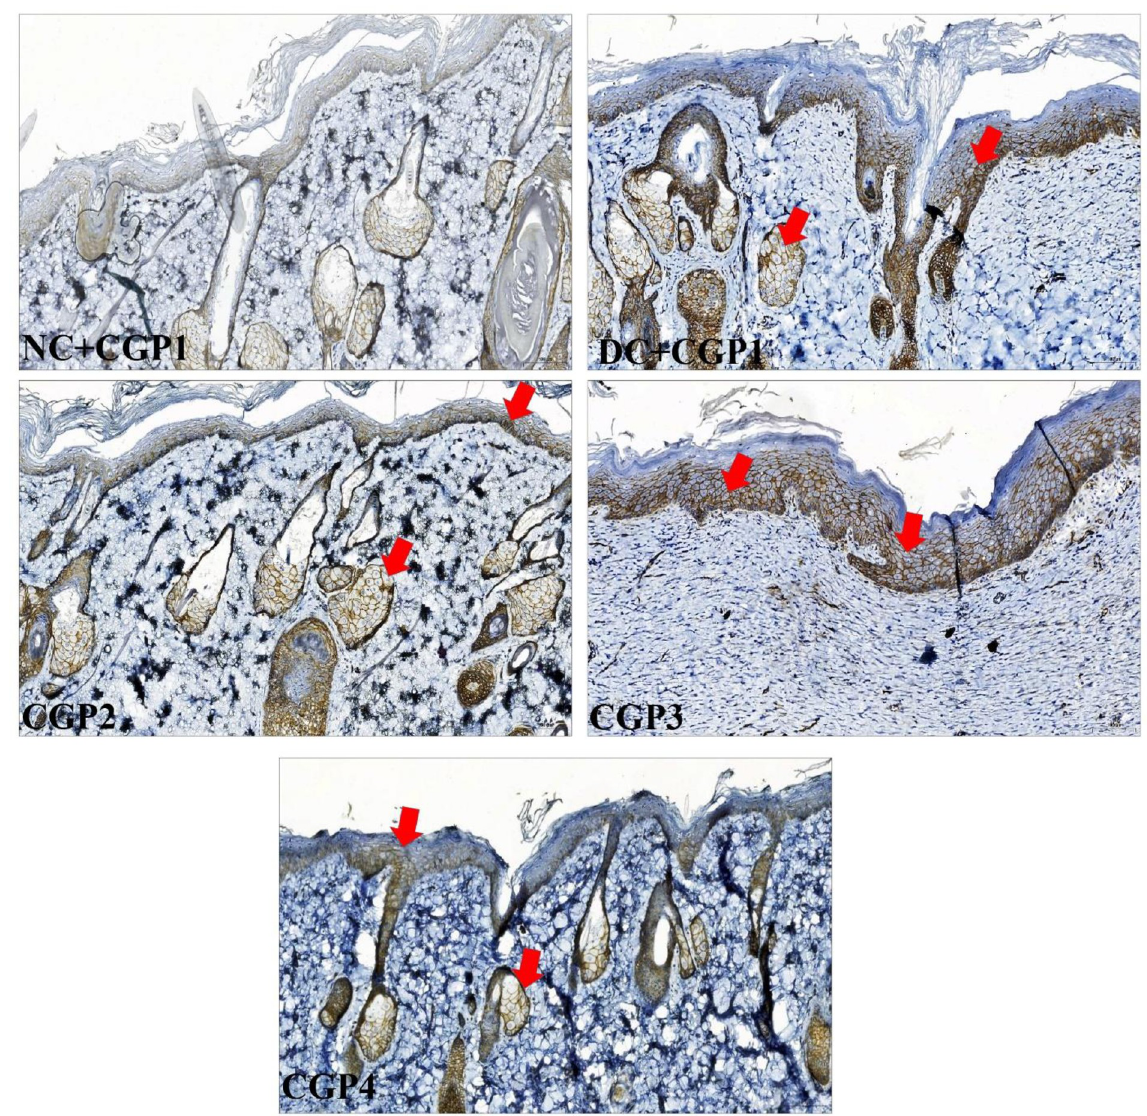
Fig 9. Effect of GC-AgNP CGPs dressing on BAX in diabetic rats. Immunohistochemistry staining of BAX (brown color). Red arrows point towards the distribution of BAX protein in brown color. NC+CGP1: Normal control dressed with blank cotton gauze; DC+CGP1: Diabetic control rats dressed with blank cotton gauze; CGP2: Diabetic rats dressed with 13.06 μ M gallocatechin and silver nanoparticle (GC-AgNP) impregnated cotton gauze patches (DC+ 13.06 μ M CGP2); CGP3: Diabetic rats dressed with 26.12 μ M gallocatechin and silver nanoparticle (GC-AgNP) impregnated cotton gauze patches (DC+ 26.12 μ M CGP3). CGP4: Diabetic rats dressed with silver sulfadiazine (DC+AgS) impregnated cotton gauze patches. Data were expressed as mean ± S.E.M (n = 6). � p < 0.05 compared to control, # p < 0.05 compared to DC. Scale bar = 100 μ